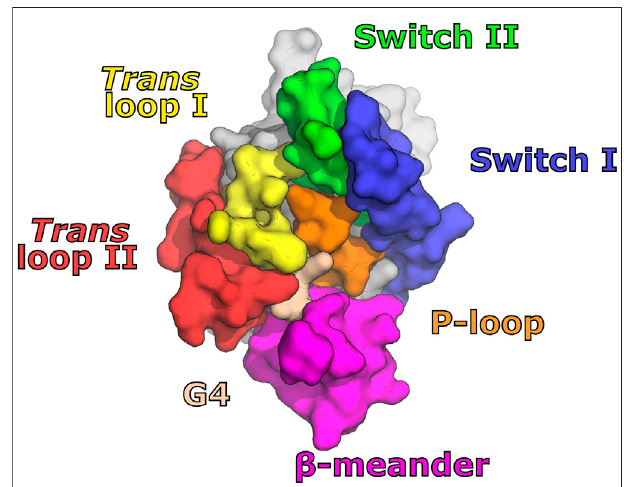
FIGURE6| MotifsinteractingatseptinG-interfaces.Sevenmaincontact regions are indicated on the G-side of the monomer. They are distributed in a diamond-like shape with switch II at the top; switch I, trans -loops 1 and 2, the P-loop and G4 at the center; and the β -meander at the